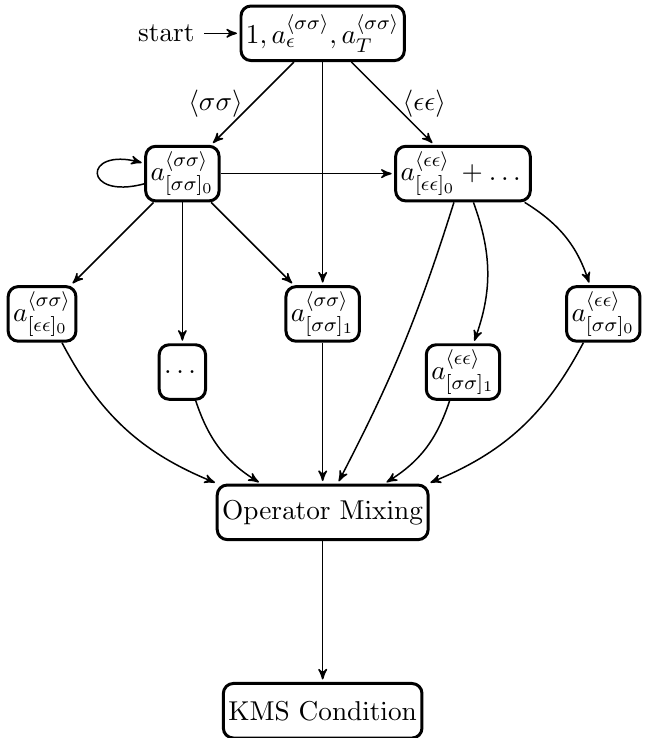
Figure 3. Diagram of the algorithm which is used to obtain the thermal coe(cid:14)cients in the 3d Ising CFT. Here, \. . . " represents contributions to the thermal coe(cid:14)cients of families other than [ (cid:27)(cid:27) ] 0 , [ (cid:27)(cid:27) ] 1 , and [ (cid:15)(cid:15) ] 0 that we account for when considering operator